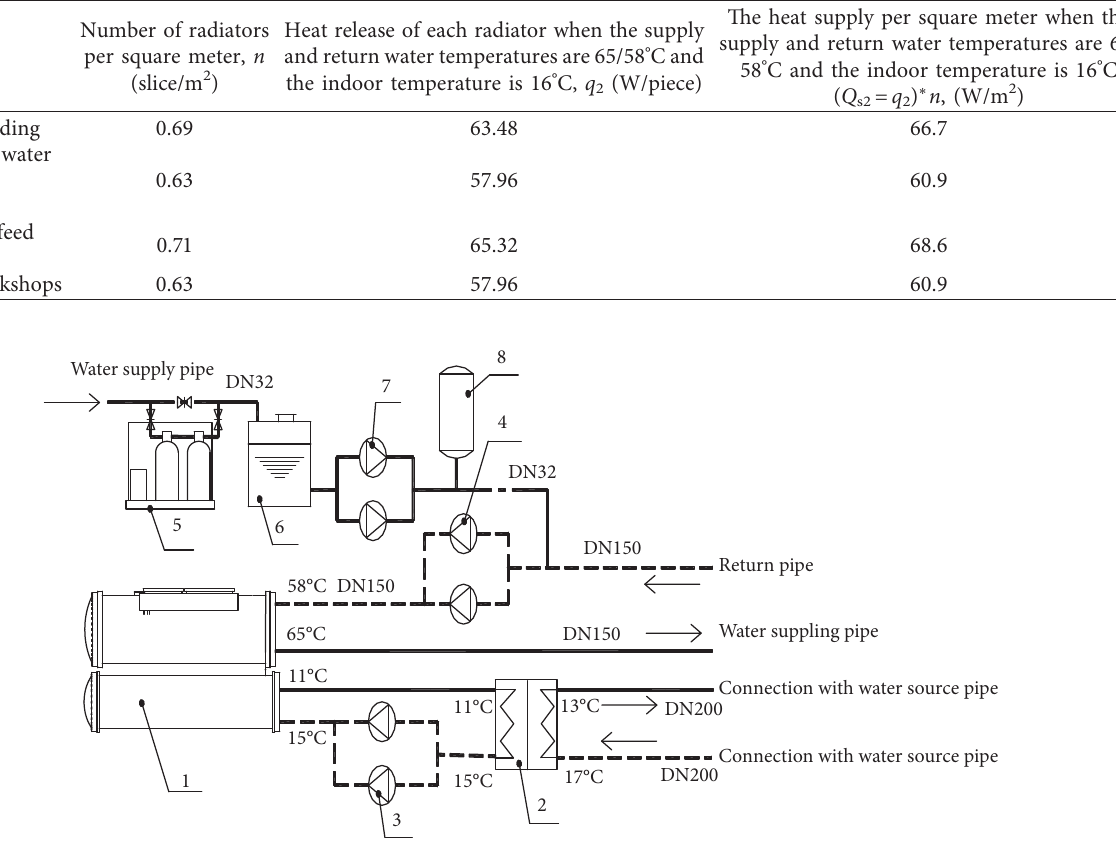
Table 4: The number of radiators in each building and its heating capacity.